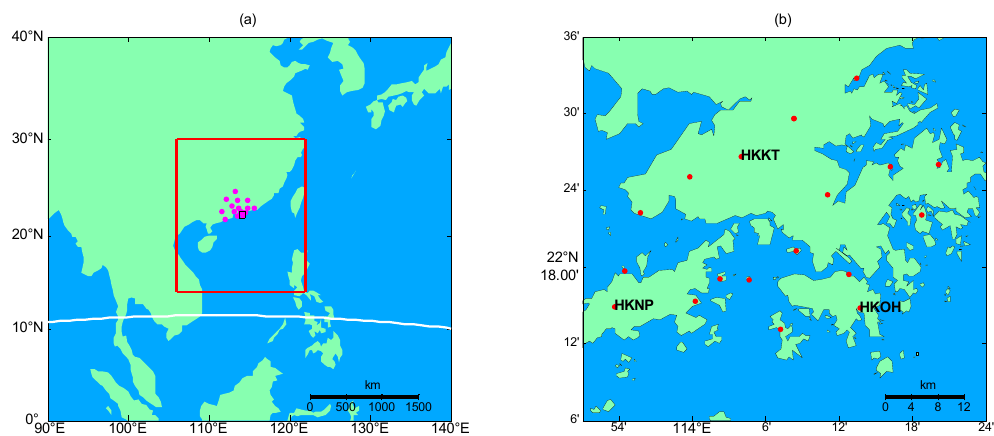
Figure 1. ( a ) Locations of the lightning network (magenta points) and Global Navigation Satellite System (GNSS) network (black rectangle). The white line shows the magnetic equator. The red rectangle indicates the study area. ( b ) Large-scale map for locations of the GNSS network (red points). Three stations— HKKT, HKNP, and HKOH, were employed in this study.